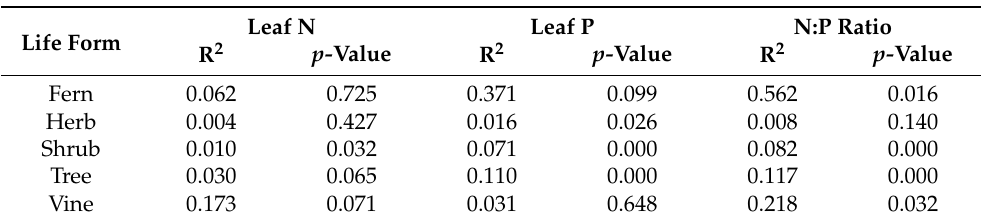
Table 1. The R 2 of relationships between aridity and leaf N and P and N:P ratio based on bivariate regression models.